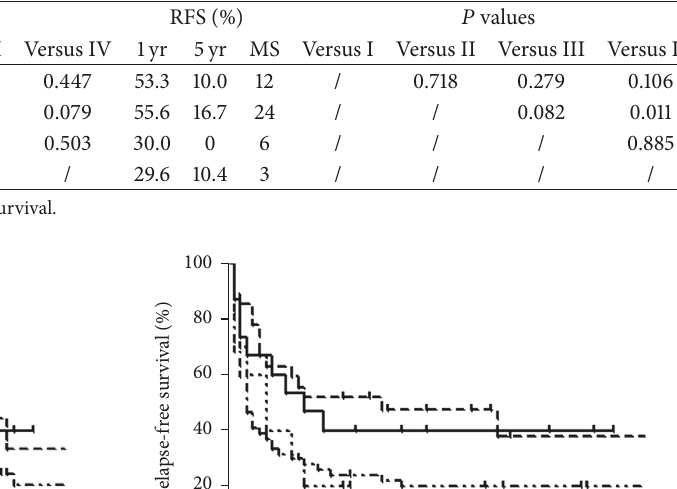
Table 4: Comparison of the survival curves.